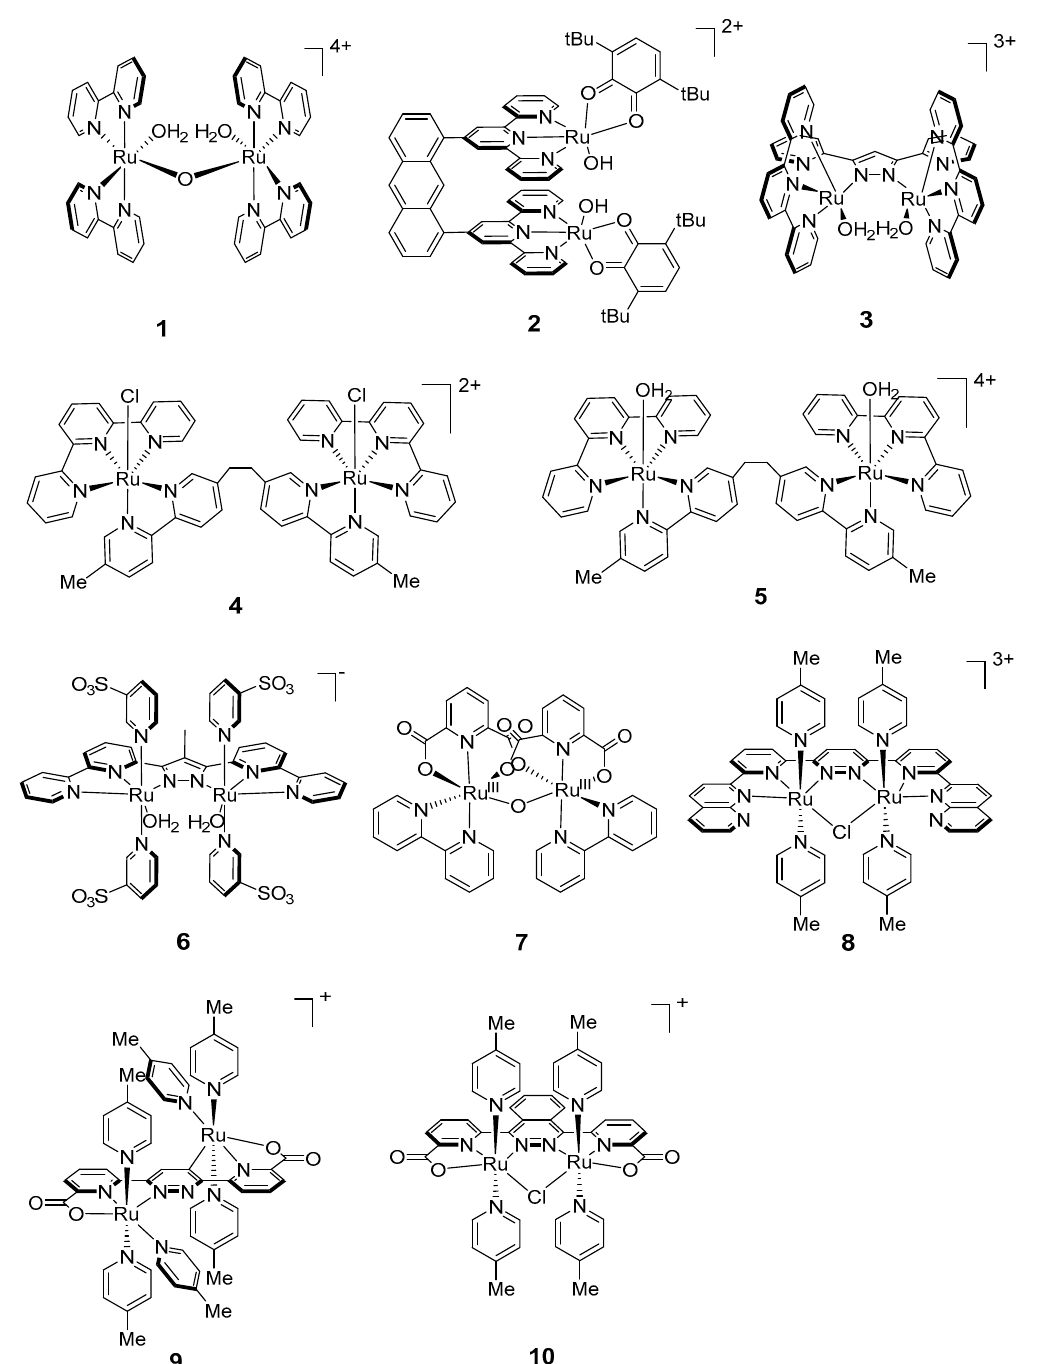
Figure 3. Chemical structures of recent dinuclear ruthenium catalysts 1–10 for water oxidation: [(H 2 O)Ru III (bipy) 2 ( μ - O)Ru III (bipy) 2 (H 2 O)] 4+ ( 1 , bipy = 2,2 ′ -bipyridine) [49]; [Ru II2 (OH) 2 (3,6- t Bu 2 qui) 2 (btpyan)] 2+ ( 2 , btpyan = 1,8-bis(2,2 ′ :6 ′ ,2 ″ -terpyridyl)anthracene, 3,6- t Bu 2 qui = 3,6-di-tert-butyl-1,2-benzoquinone) [74]; [(H 2 O)Ru II (terpy) 2 ( µ